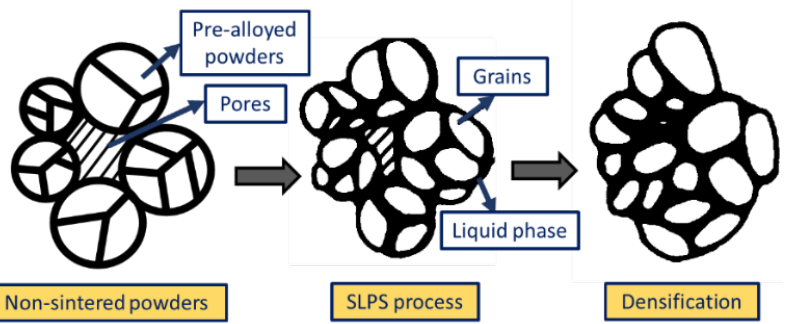
Figure 5. Scanning electron microscopy images of sintered samples prepared with ( a ) Cu-SCuP [105] and ( b – d ) W-Cu [106].